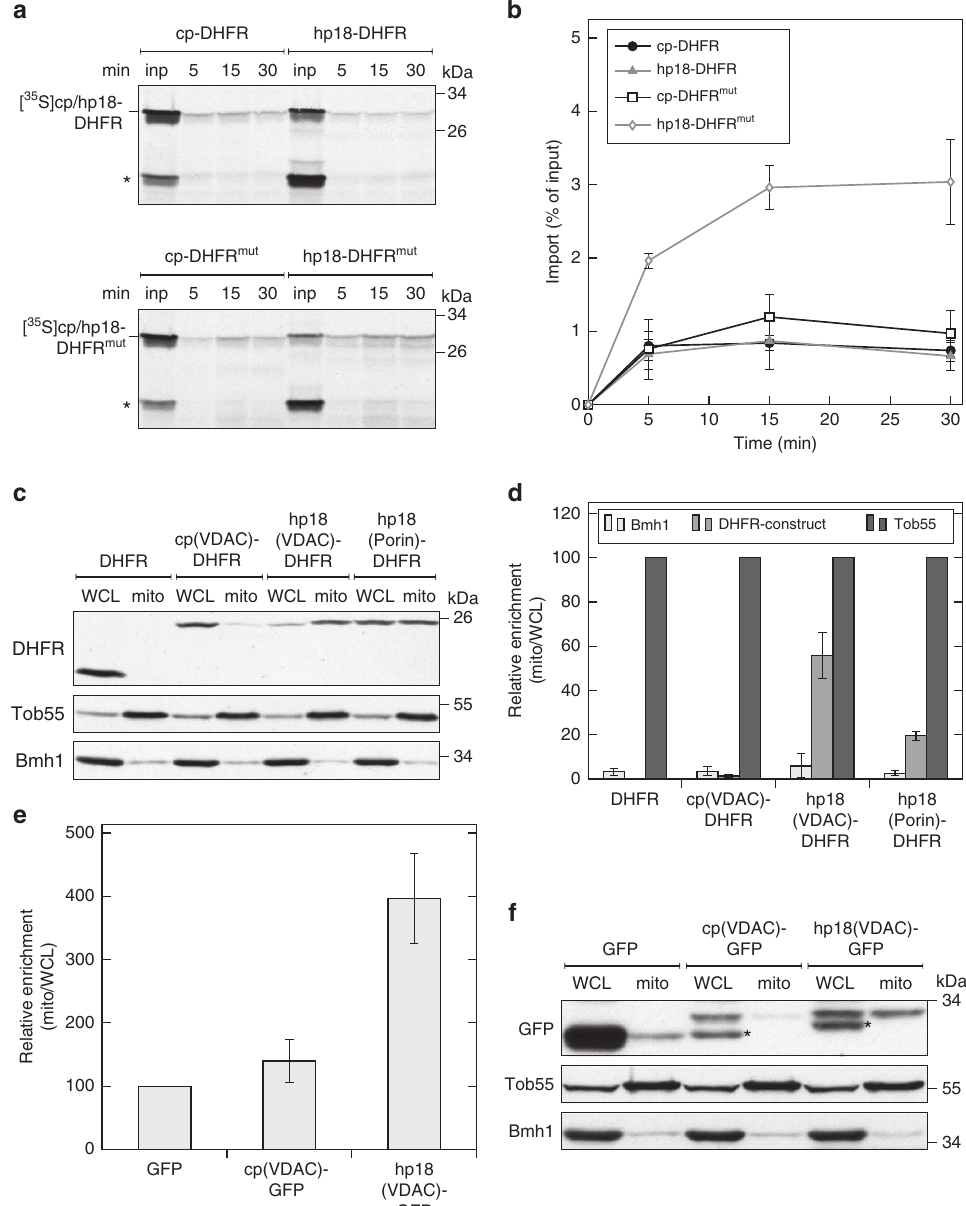
Figure 2 | b -Hairpin peptides can target passenger proteins to mitochondria. ( a ) The specified radiolabelled fusion proteins were imported into isolated mitochondria for the indicated time periods. An asterisk marks a translation product generated from an internal ATG codon corresponding to DHFR or DHFR mut . inp, 5% lysate input. ( b ) The intensity of the bands from three independent experiments as in ( a ) was quantified and plotted against the time of the import reaction. Error bars represent s.d. ( c ) Crude mitochondria were isolated from yeast cells expressing DHFR alone or the indicated fusion proteins. Samples from the whole-cell lysate (WCL) and the crude mitochondria (mito) were analyzed by SDS–PAGE and immunodecoration with antibodies against the indicated proteins. Tob55, mitochondrial b -barrel protein; Bmh1, cytosolic protein. ( d ) The intensity of the bands from three independent experiments as in ( c ) was quantified and the mitochondrial enrichment was calculated by dividing the signal in the mitochondrial fraction by the one in the whole-cell lysate. The mitochondrial enrichment of Tob55 was set to 100. The results represent mean ± s.d. from three independent experiments. ( e ) Samples from the whole-cell lysate and crude mitochondrial fractions of yeast cells expressing the indicated proteins were analyzed for their GFP fluorescence. The mitochondrial enrichment of the GFP signal was calculated and the one of GFP-expressing cells was set to 100. The results represent mean ± s.d. from three independent experiments. ( f ) The samples from the experiments in ( e ) were analyzed by SDS–PAGE and immunodecoration with antibodies against the indicated proteins. An asterisk marks a shorter form of the fusion proteins resulting probably from